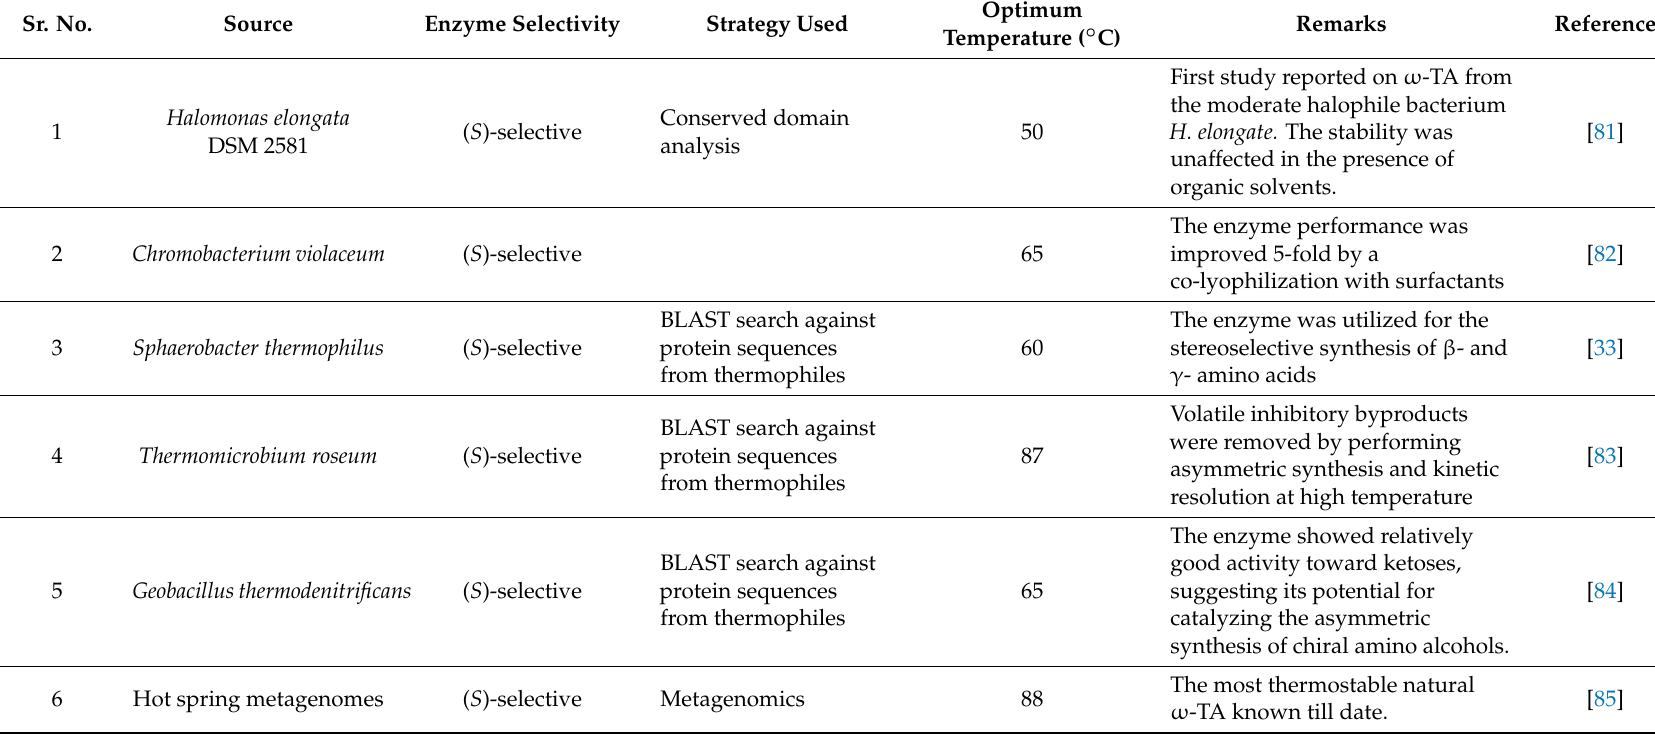
Table 1. Selected examples of recently discovered thermostable ω